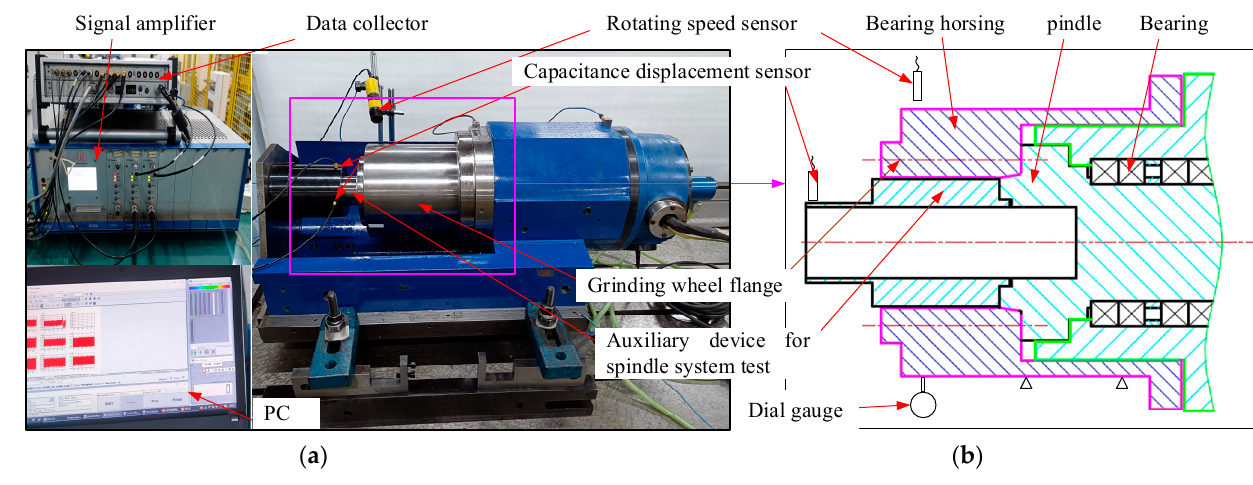
Figure 14. Vibration characteristics test rig for grinding machine spindle system: ( a ) experimental setup; ( b ) schematic of experimental setup.